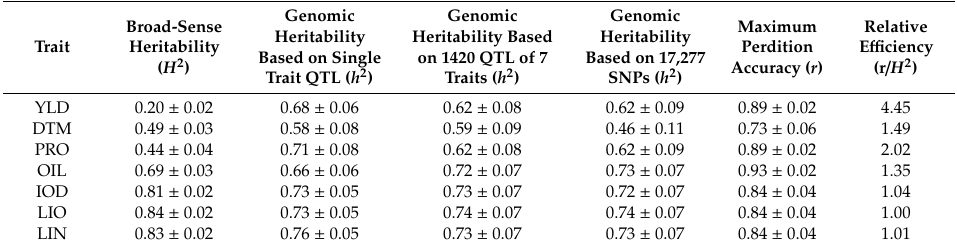
Table 6. Broad-sense and genomic heritability of seven